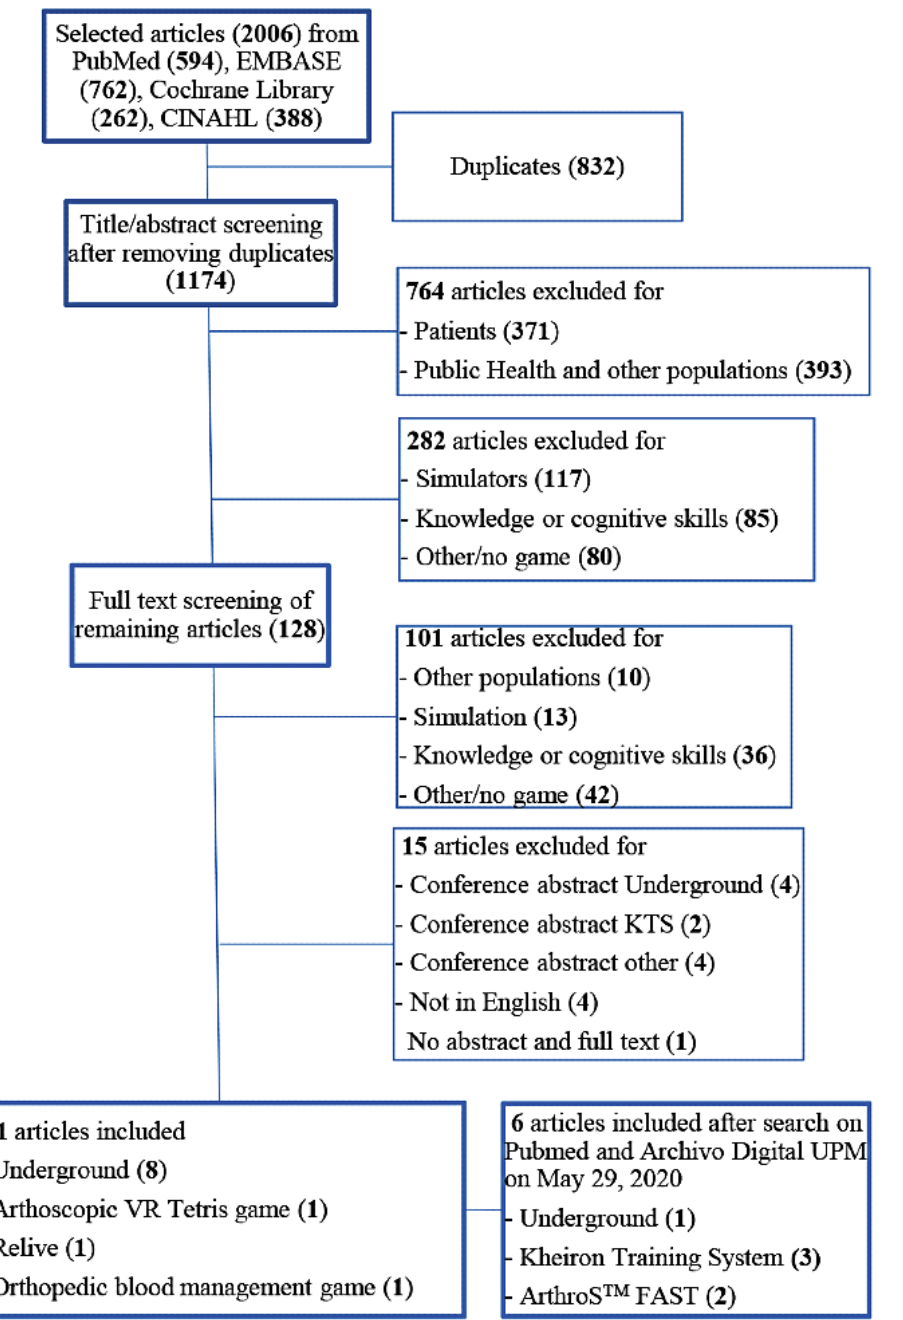
Figure 1. Flow chart of study inclusion. KTS: Kheiron training